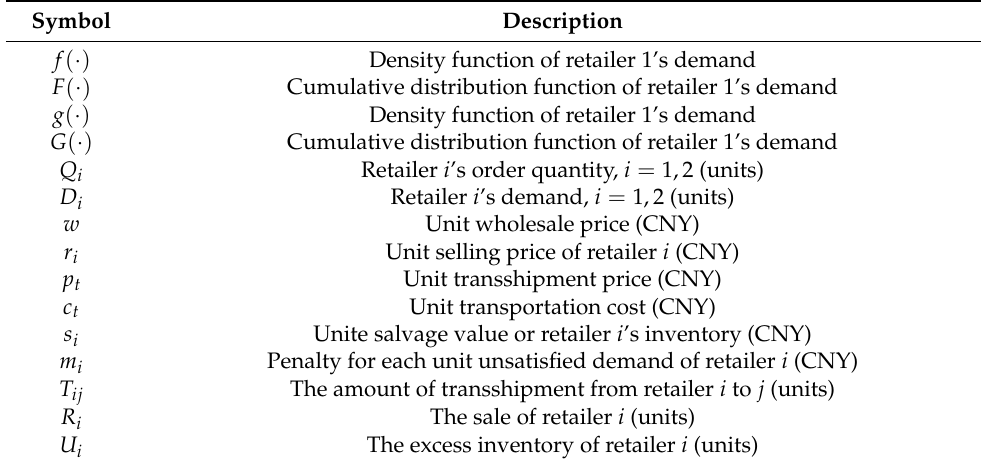
Table 1. List of